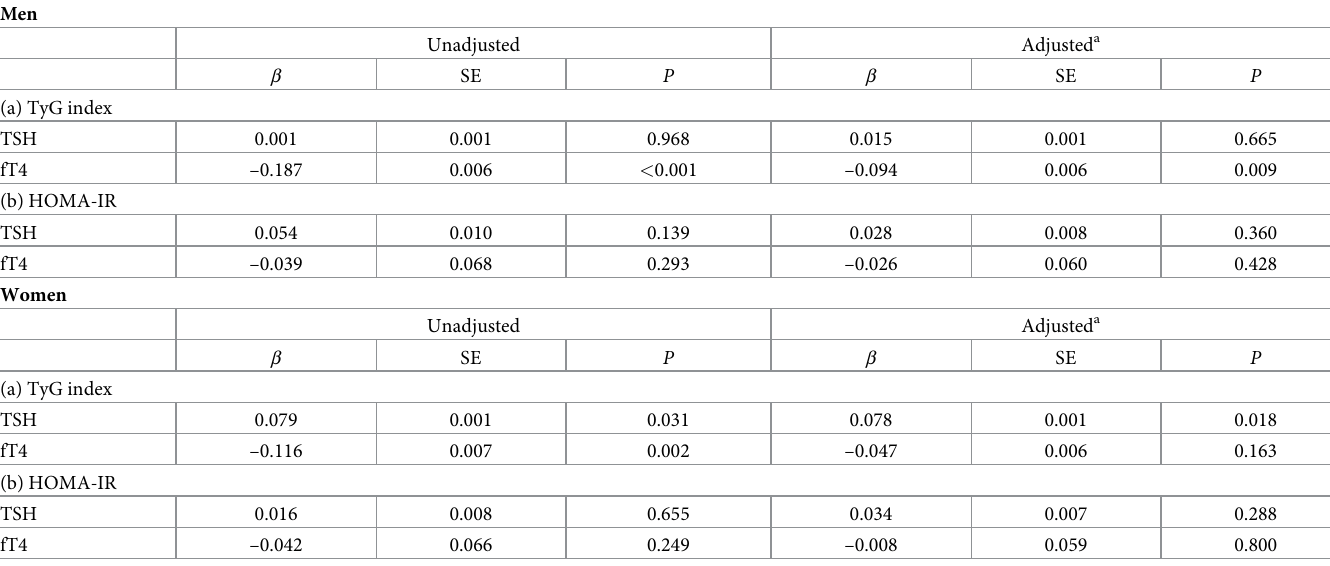
Table 2. Associations of thyrotropin and free thyroxine levels with TyG index and HOMA-IR.